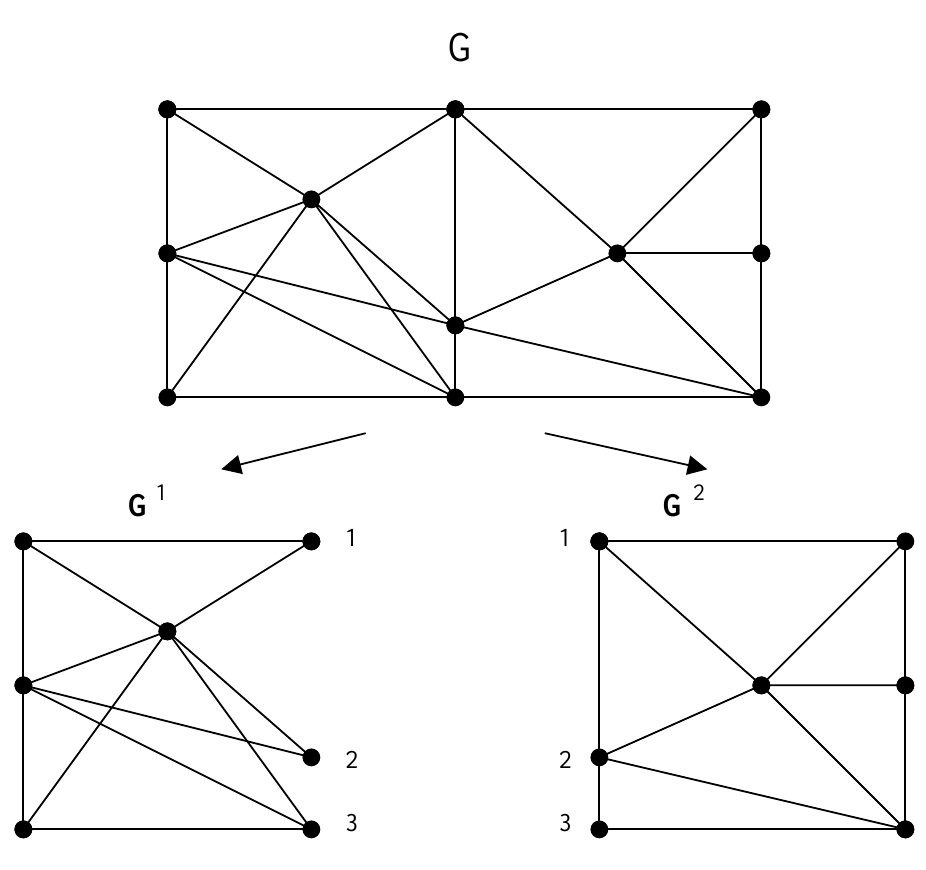
Figure 1 Decomposition of a graph with 11 nodes and 24